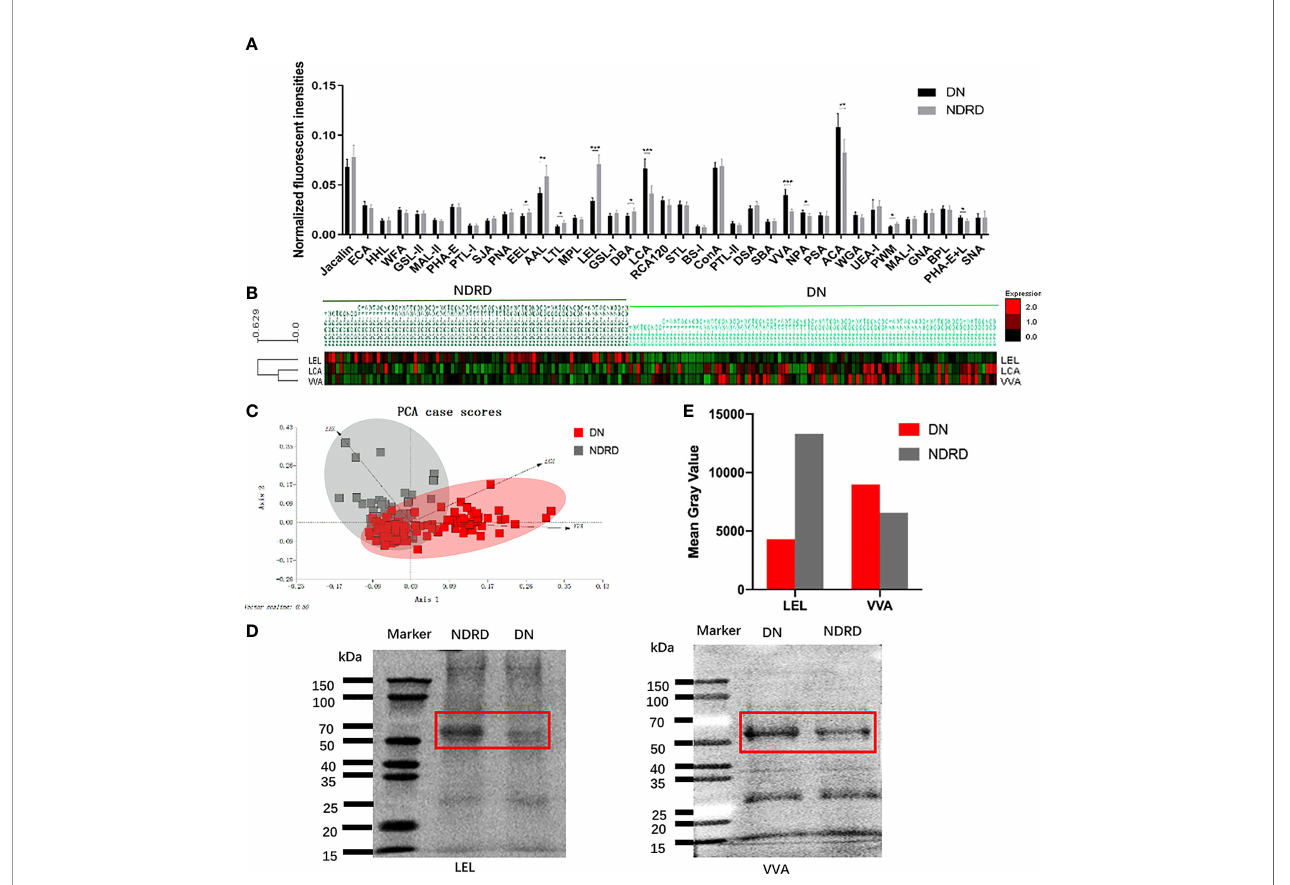
FIGURE 2 | Exhibition and con fi rmation of differentiation with DN and NDRD using lectins. (A) Comparison of all candidate lectins in salivary samples from DN and NDRD patients. The normalised fl uorescence intensities of 37 lectins from DN and NDRD patients were compared based on fold-change and one-way ANOVA (*p < 0.05, **p < 0.01, and ***p < 0.001). Data are presented as the mean ± 95% CI. (B) Hierarchical clustering analysis of the three lectins with signi fi cant differentiation of NFIs between DN and NDRD. Glycan pro fi les of DN and NDRD patients were clustered (average linkage, correlation similarity). Samples are listed in columns, and lectins are listed in rows. The colour intensity of each square indicates the expression levels relative to other data. Red, high; green, low; black, medium. (C) The normalised glycopattern abundances of three lectins related to the two groups were subjected to principal component analysis (PCA). DN and NDRD samples were visualised by red and grey shadows, respectively. (D) Con fi rmation of salivary glycopatterns from DN and NDRD groups using LEL and VVA lectins was performed by lectin blotting. (E) Mean grey value of each apparent difference band was obtained using ImageJ. DN, diabetic nephropathy; NDRD, non-diabetic renal disease; NFIs, normalised fl uorescence intensities; LEL, Lycopersicon esculentum lectin; VVA, Vicia villosa